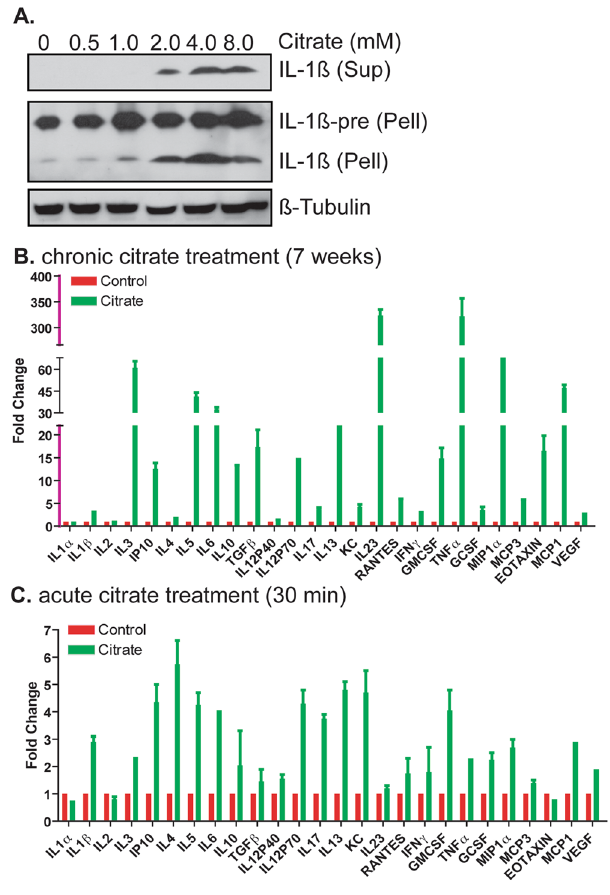
Figure 4. Citrate treatment enhances cytokines secretion. ( A ) Citrate induces IL-1 β secretion in PMA-induced macrophages. The full-length blots are presented in Supplemental Figure S13. ( B ) Chronic citrate treatment enhances cytokine secretion in plasma from Ras-driven mice. ( C ) Acute citrate treatment affects cytokine secretion in plasma from Ras-driven mice. Sup: supernatant; Pell: